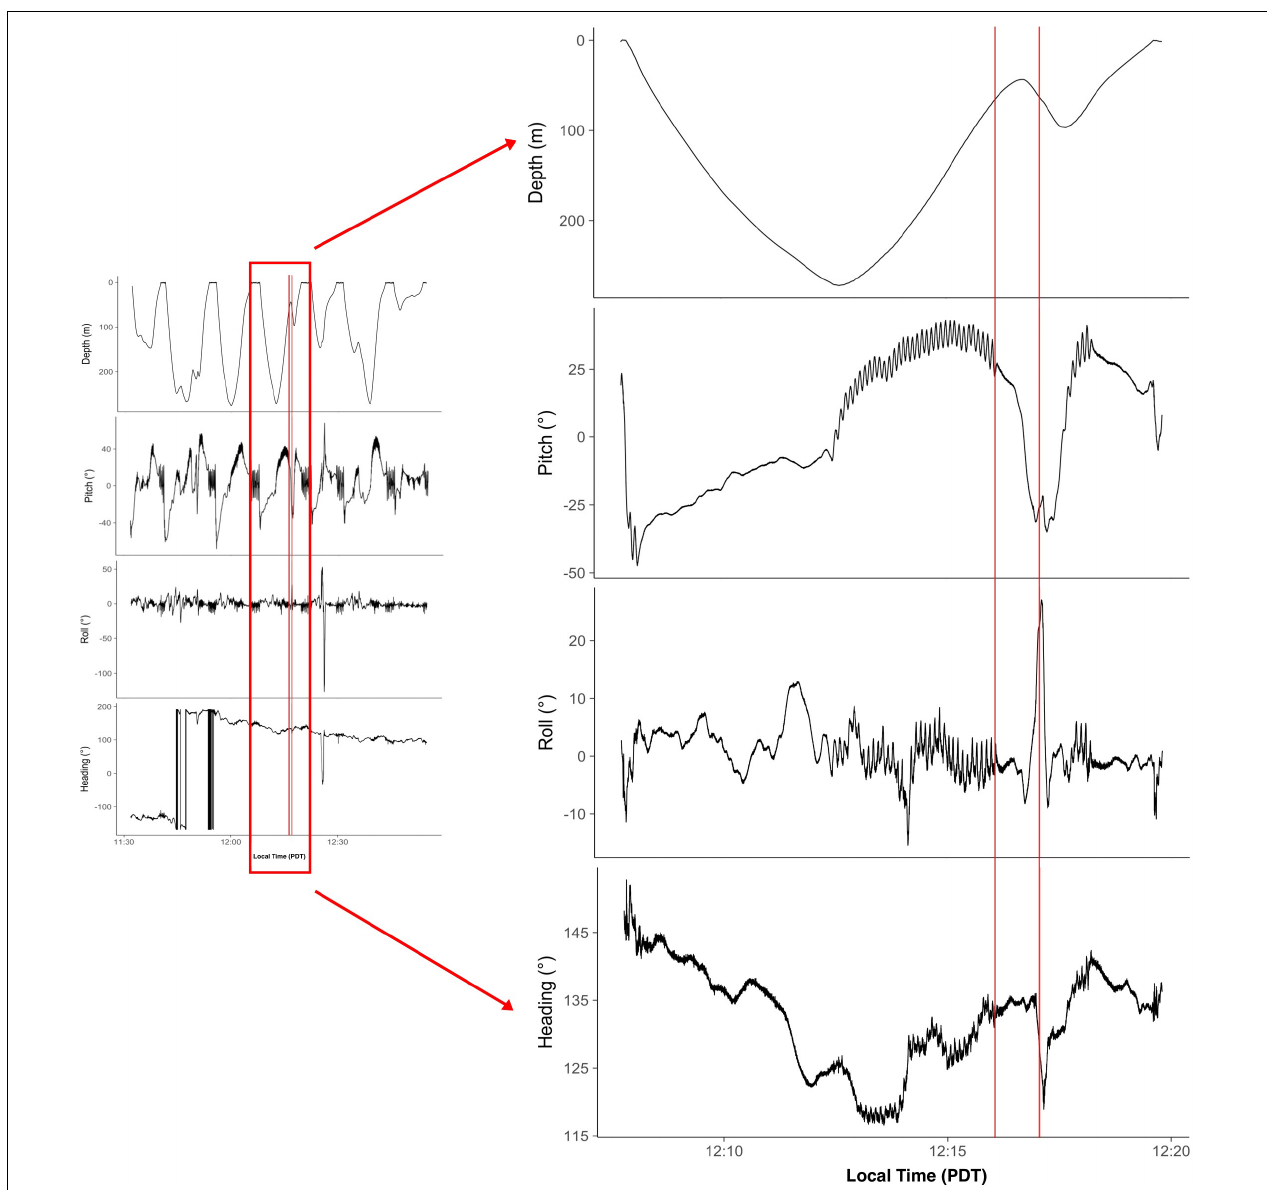
FIGURE 2 | Close up of fine scale kinematic data recorded during the CPA with the Mokihana. The first panel illustrates the depth (meters), the second panel shows pitch (degrees), the third panel illustrates roll (degrees), and the fourth panel illustrates heading (degrees). The first solid red line indicates the onset of a behavioral response by the whale. The second solid red line indicates the CPA with the